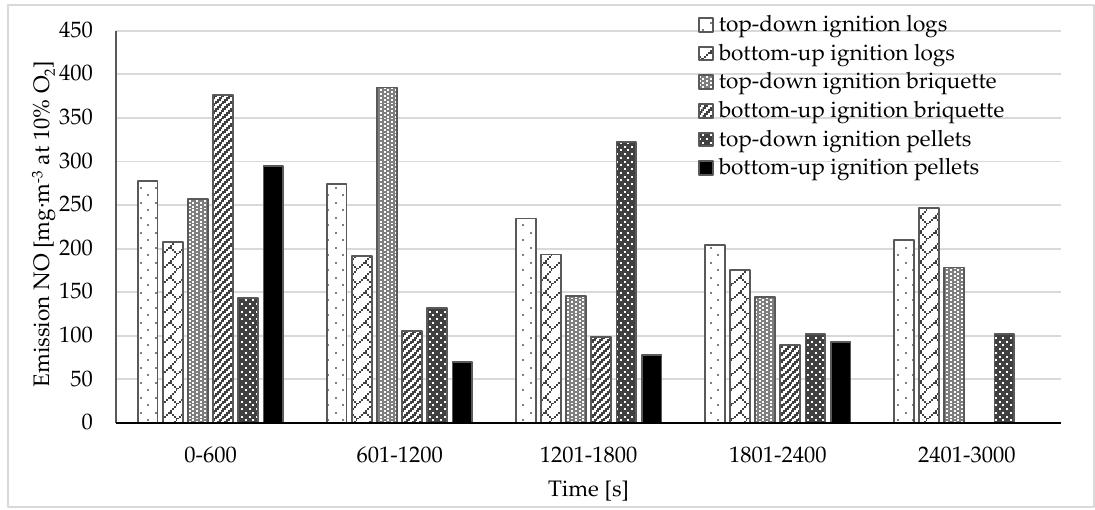
Figure 6. Indicators of nitic oxide emission during the combustion of the selected biomass forms.